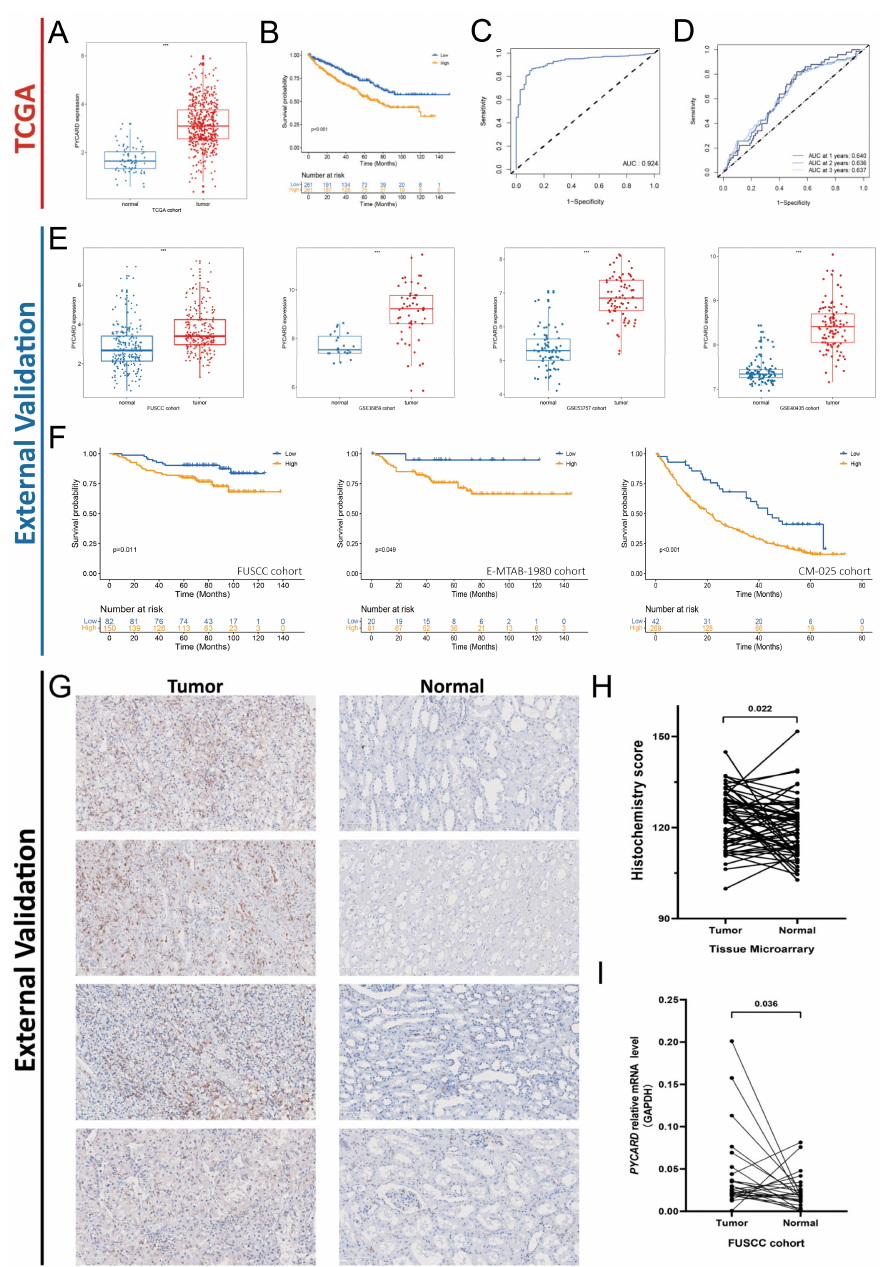
Figure 4. Upregulation of PYCARD expression is associated with prognosis in ccRCC. ( A ) PYCARD RNA expression is increased in ccRCC. ( B ) Higher PYCARD expression is associated with worse OS in KIRC. ( p < 0.001) ( C ) Diagnostic value of PYCARD expression in KIRC cohort. ( D ) Prognostic value of PYCARD expression in KIRC cohort. ( E ) The PYCARD expression is upregulated in four external validation cohorts (FUSCC Proteomic Cohort, GSE40435, GSE53757, GSE36859). ( F ) Higher PYCARD expression is associated with worse OS in three external validation cohorts (FUSCC Proteomic Cohort, E-MTAB-1980, CM-025). ( G ) The immunochemistry staining of the TMA. The 20 × imaging was used for scanning. ( H ) The quantitative histochemistry score of TMA demonstrated that PYCARD protein increased in ccRCC ( p = 0.022). ( I ) Quantitative PYCARD relative mRNA expression of 26 ccRCC patients is increased in ccRCC compared to normal tissue ( p = 0.036). (*** p < 0.001) (TMA, tissue